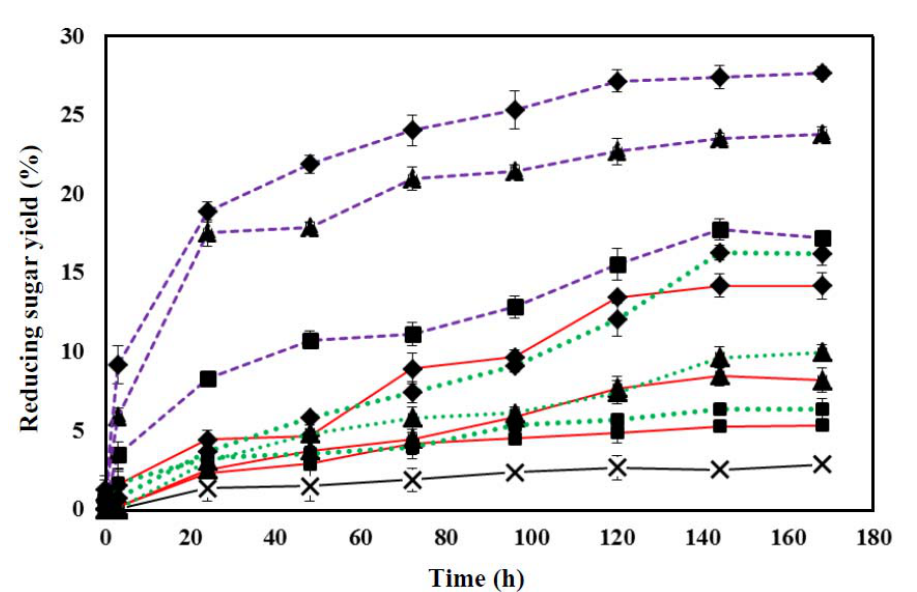
Figure 4. Time course of reducing sugar yield (%) during the hydrolysis of rubberwood ( a) untreated (×); ( b ) pretreated with C. subvermispora (---); ( c ) T. versicolor ( ─